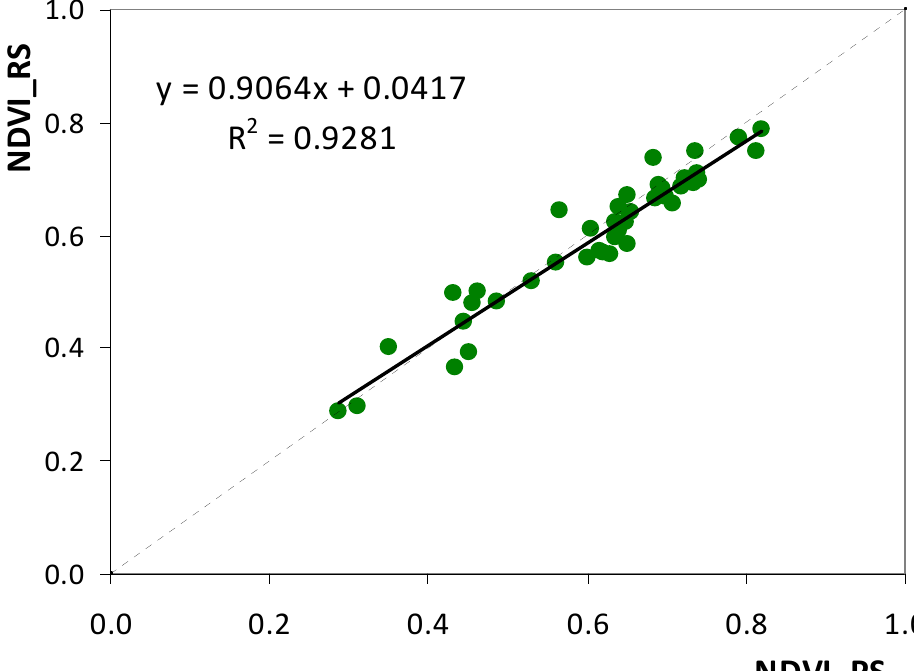
Figure 19. Regression analysis between NDVI obtained by proximal sensing (NDVI PS ) and NDVI obtained by remote sensing (NDVI RS ).